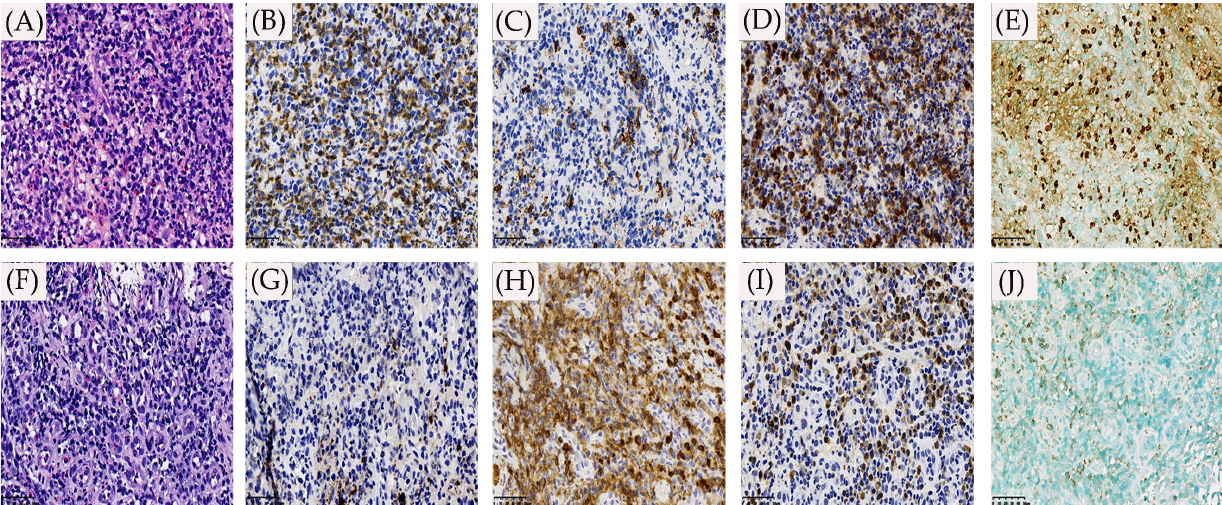
Figure 2. From left to right ( A – E ) Immunohistochemistry and in situ hybridization with Epstein-Barr virus-encoded small RNA (EBER) probe in the first esophageal biopsy in Peking University First Hospital. ( A – E ): HE × 40, CD3, CD20, CD79a, EBER. ( F – J ) Immunohistochemistry and in situ hybridization with Epstein–Barr virus-encoded small RNA (EBER) probe in the second esophageal biopsy in Peking University First Hospital. ( F – J ): HE × 40, CD20, CD79a, MUM1, EBER.